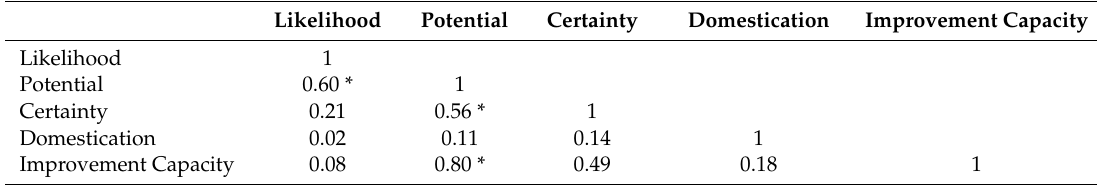
Table 3. Correlation matrix for the selected variables. Values are Spearman ρ . Significant correlations are marked with